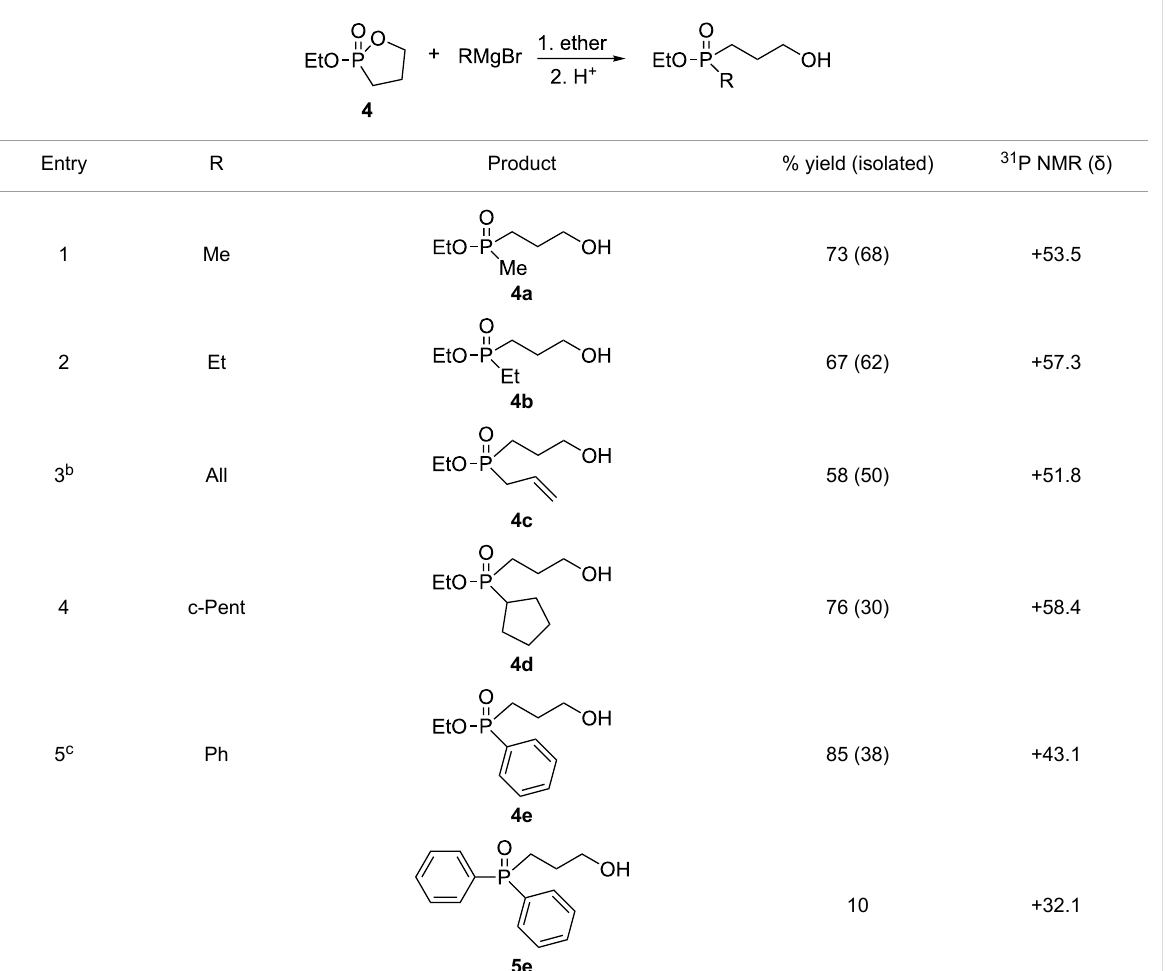
Table 1: Synthesis of γ -hydroxypropyl (±)-phosphinates a and related